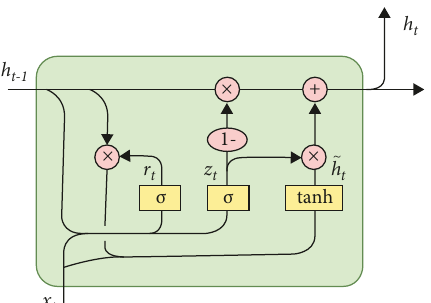
Figure 2: The internal structure diagram of